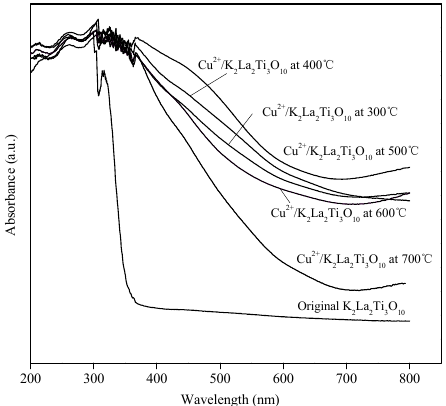
Figure 2. UV-Vis absorption spectra of original K 2 La 2 Ti 3 O 10 , Cu 2+ /K 2 La 2 Ti 3 O 10 calcined at 300, 400, 500, 600 and 700 ◦